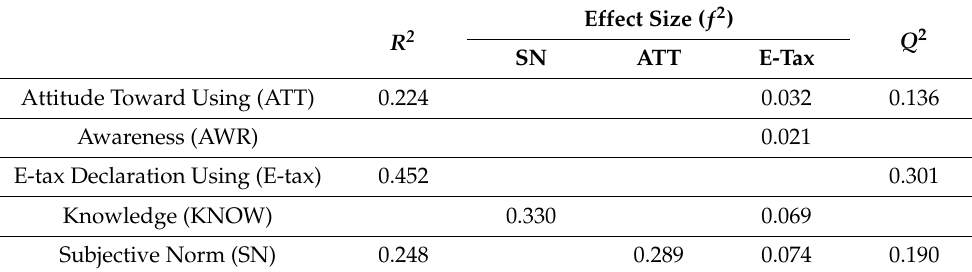
Effect Size (ƒ 2 ) Q 2 R 2 SN ATT E-Tax